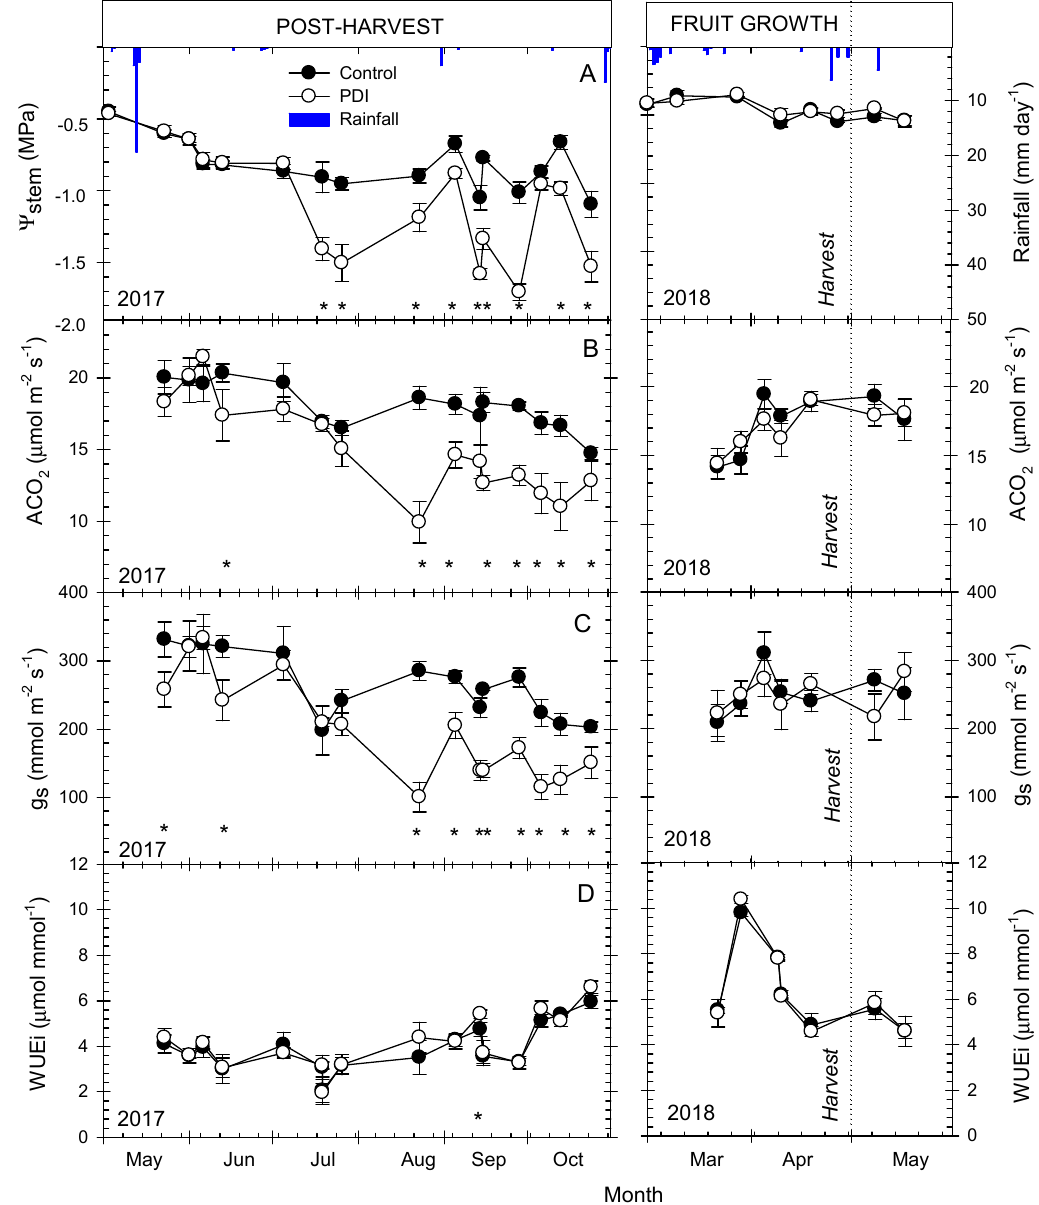
Figure 3. Seasonal evolution of ( A ) midday stem water potential ( Ψ stem , MPa) and daily rainfall, ( B ) net CO 2 assimilation rate (ACO 2 , μ mol m − 2 s − 1 ), ( C ) stomatal conductance (g s , mmol m − 2 s − 1 ), and ( D ) instantaneous water use efficiency (WUEi, μ mol mmol − 1 ), in control ( ● ) and PDI (o) treatments during the 2017/2018 growing season. Values are means ± SE ( n = 4). Asterisks indicate statistically significant differences between treatments at p ≤ 0.05.